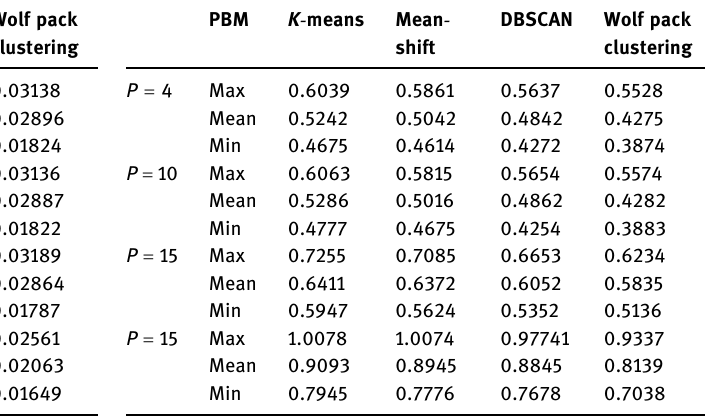
Table 4: DB performance with di ff erent numbers of data